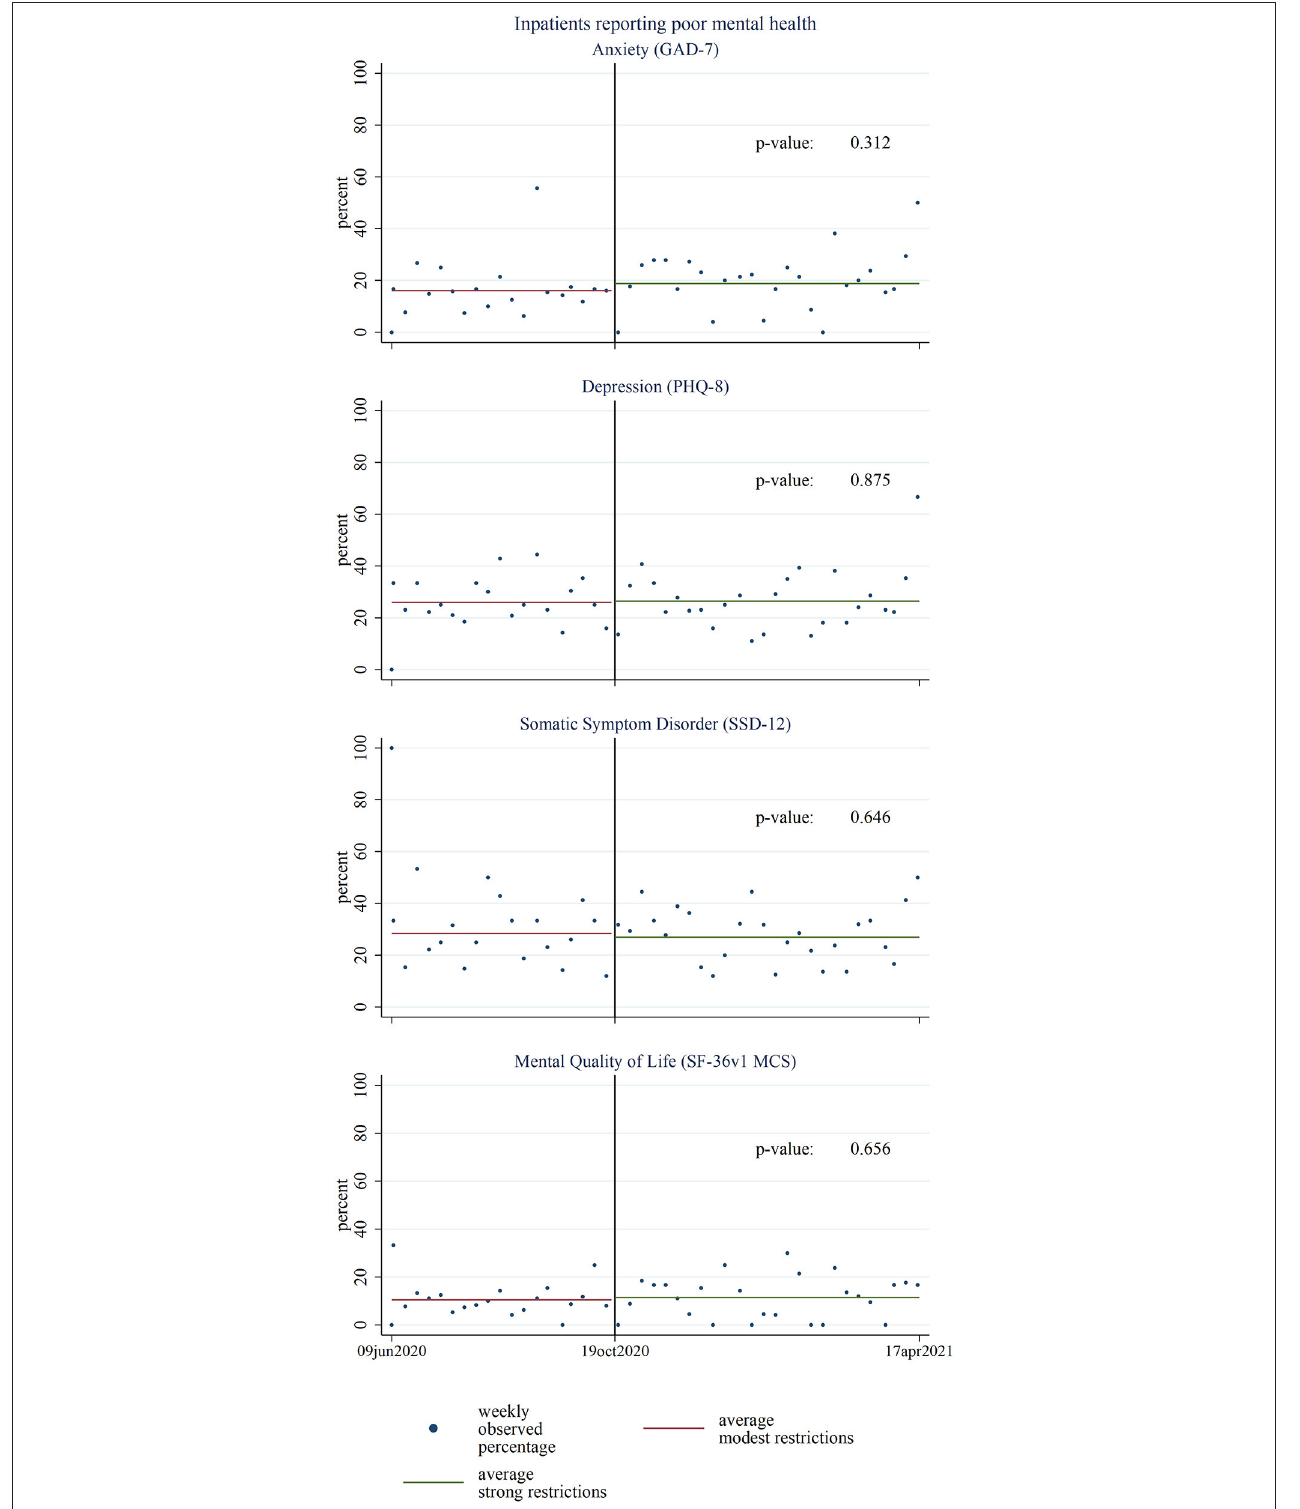
FIGURE 3 | Comparison of percentage of hospital inpatients’ mental health according to respective mental health assessment tools during the pre-period of modest and the post-period of strong coronavirus disease 2019 (COVID-19) restrictions ( N = 873). P -values are based on unadjusted linear regression analyses. GAD-7, 7-item General Anxiety Disorder questionnaire; PHQ-8, 8-item Patient Health Questionnaire; SSD-12, 12-item Somatic Symptom Disorder questionnaire; SF-36v1, Short Form 36, version 1; MCS, mental component summary.